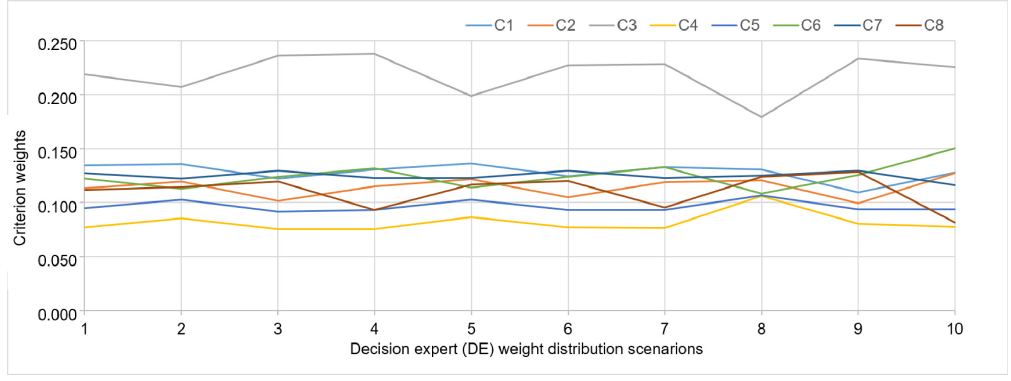
Fig 2. Flowchart of the proposed methodology.